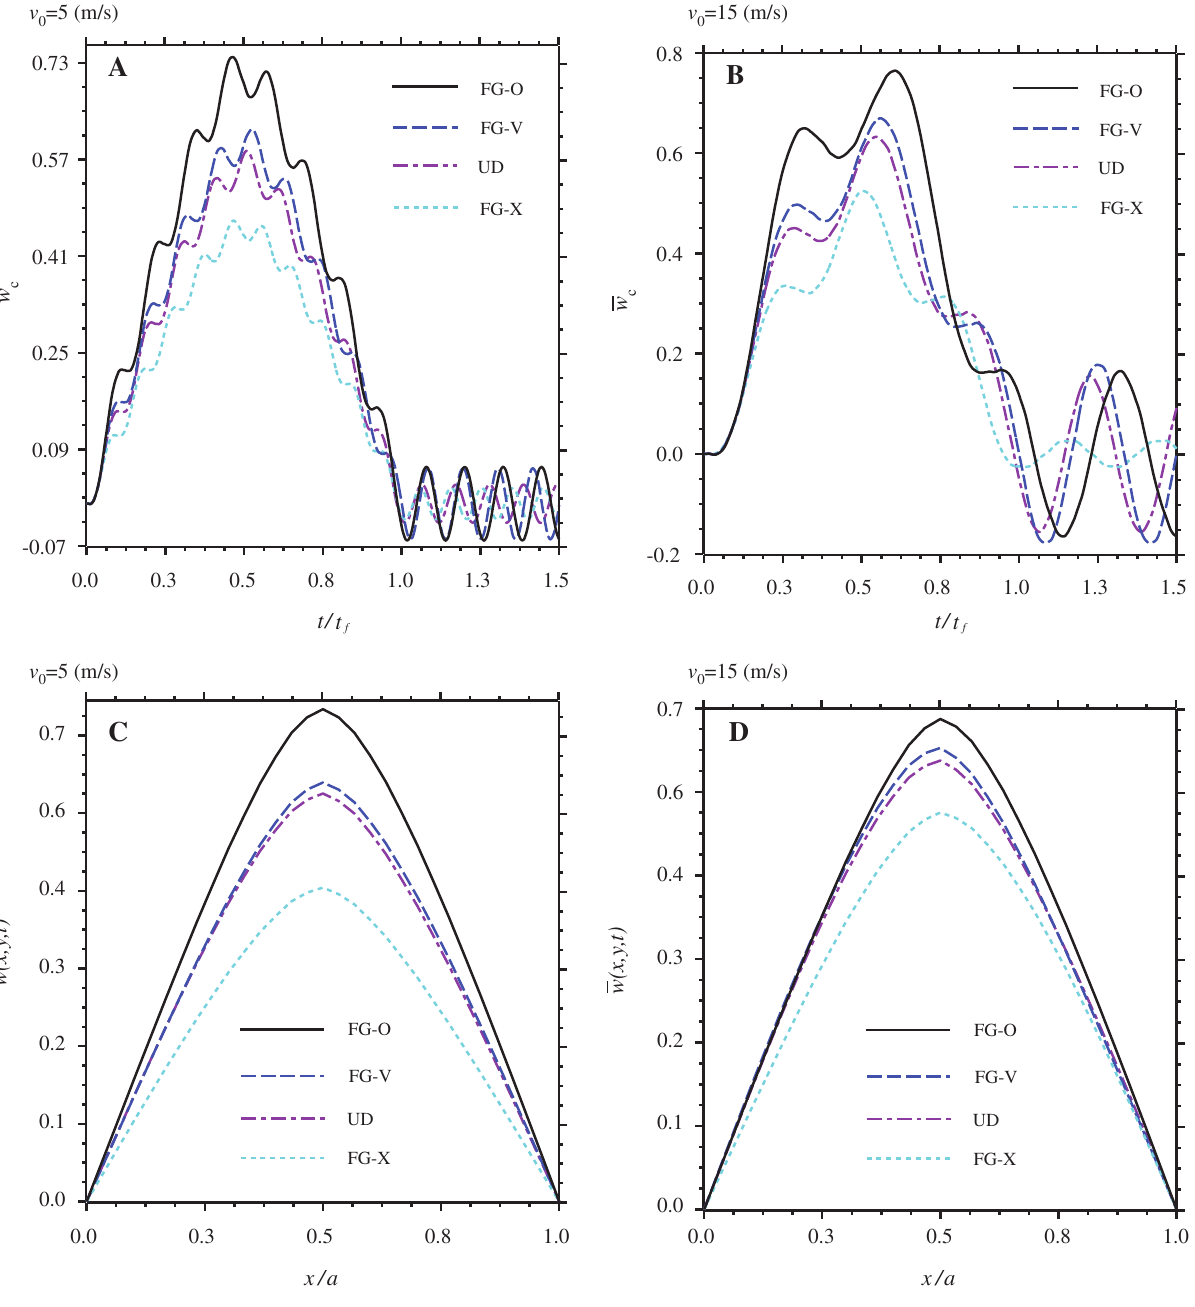
Figure 3 The influence of three different CNT distributions on the dynamic behavior of CNTRC plates with simply supported edges: (A, B) the time history of the nondimensional center deflection; (C, D) the profile of the material line y = b /2 at t = 0.5 t